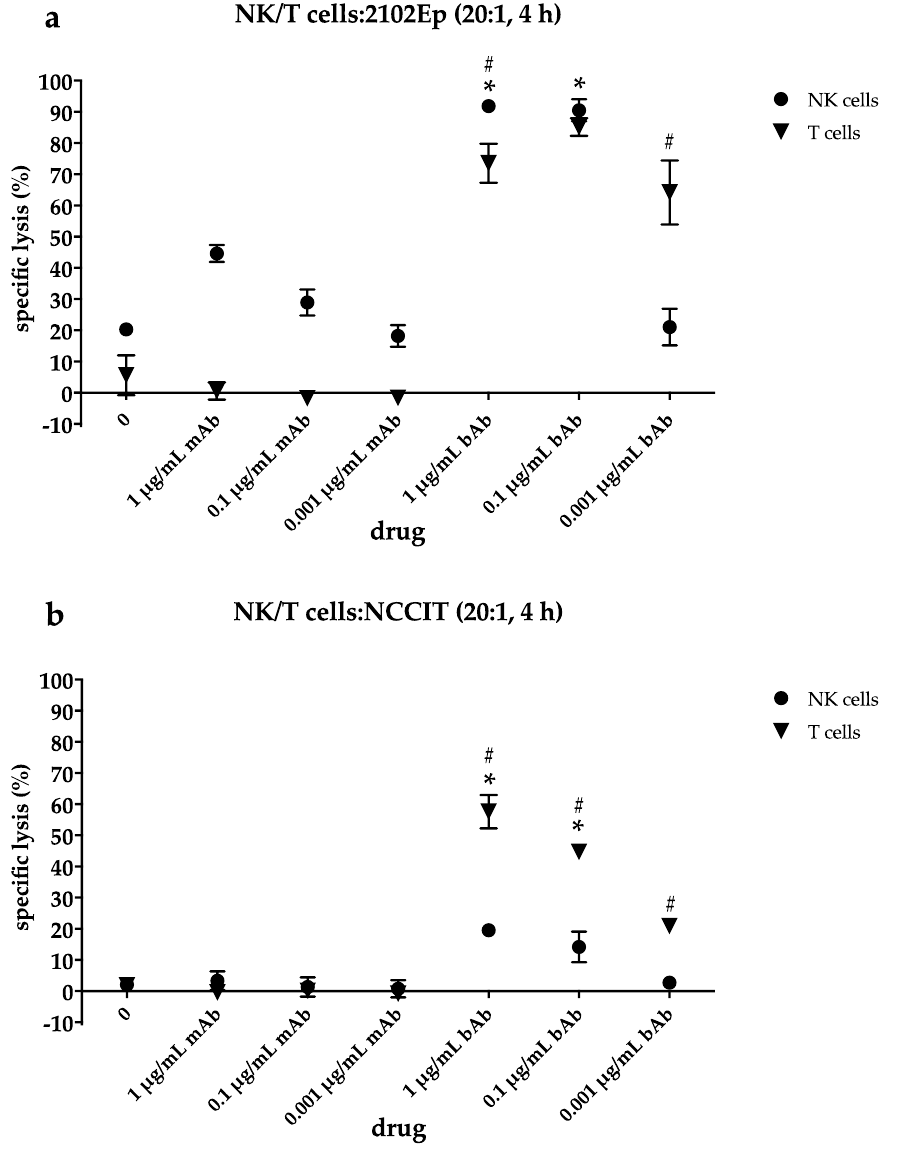
Figure 4. In the presence of either isolated natural killer (NK) and T cells, EpCAM expression exerts significant influence on the extent of bAb-mediated tumor cell lysis. ( a ) 2102Ep or ( b ) NCCIT cells were cultivated for 4 h with isolated NK or T cells at an effector:target cell ratio of 20:1 and stated concentrations of monoclonal EpCAM-Ab Vu1D9 (mAB) or the bispecific trifunctional EpCAM/CD3-Ab Catumaxomab (bAb). Antibody-dependent cytotoxicity was assessed by europium release assay in triplicates and expressed in percentage of dead cells. Data are presented as mean ± SD of two independent experiments. Statistically significant difference between mAb- and bAb-mediated NK cell-induced cellular lysis is marked by an asterisk (* p < 0.001). The hash (#) indicates a statistically significant difference between NK or T cell-induced cell death mediated by the bAb ( p < 0.001). In the absence of a specific binding site for T cells, EpCAM-mAb facilitates only NK but no T- cell dependent cytotoxicity. In the EpCAM-“high” EC line 2102EP, mAb-mediated cell death is substantial at the highest mAb concentration in the presence of NK cells but declines from 44.6 ± 2.7% at 1 µg/mL mAb to 28.9 ± 4.1% at 0.1 µg/mL and 18.2 ± 3.5% at 0.001 µg/mL mAb (Figure 4a). The bispecific EpCAM/CD3-binding antibody engages isolated NK cells to an even more powerful